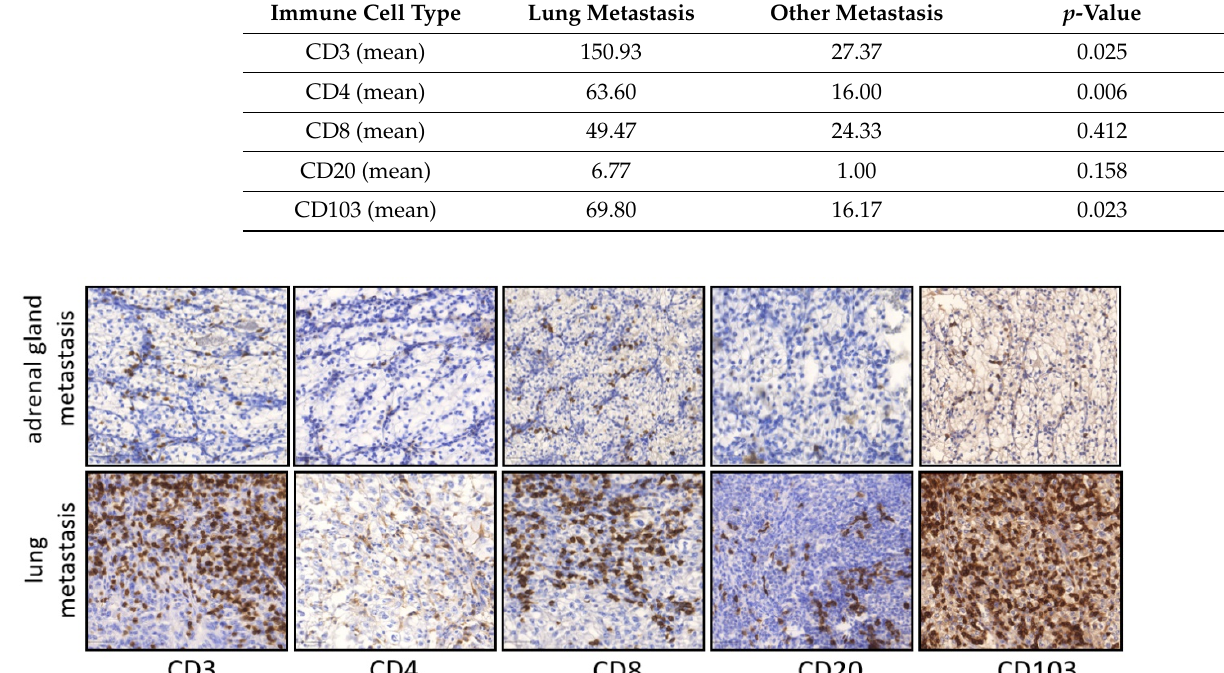
Table 5. Comparison of immune cells infiltrating metastases of ccRCC in relation to clinico-patho- logical data (Mann–Whitney U test, Bonn cohort, n = 25 patients).